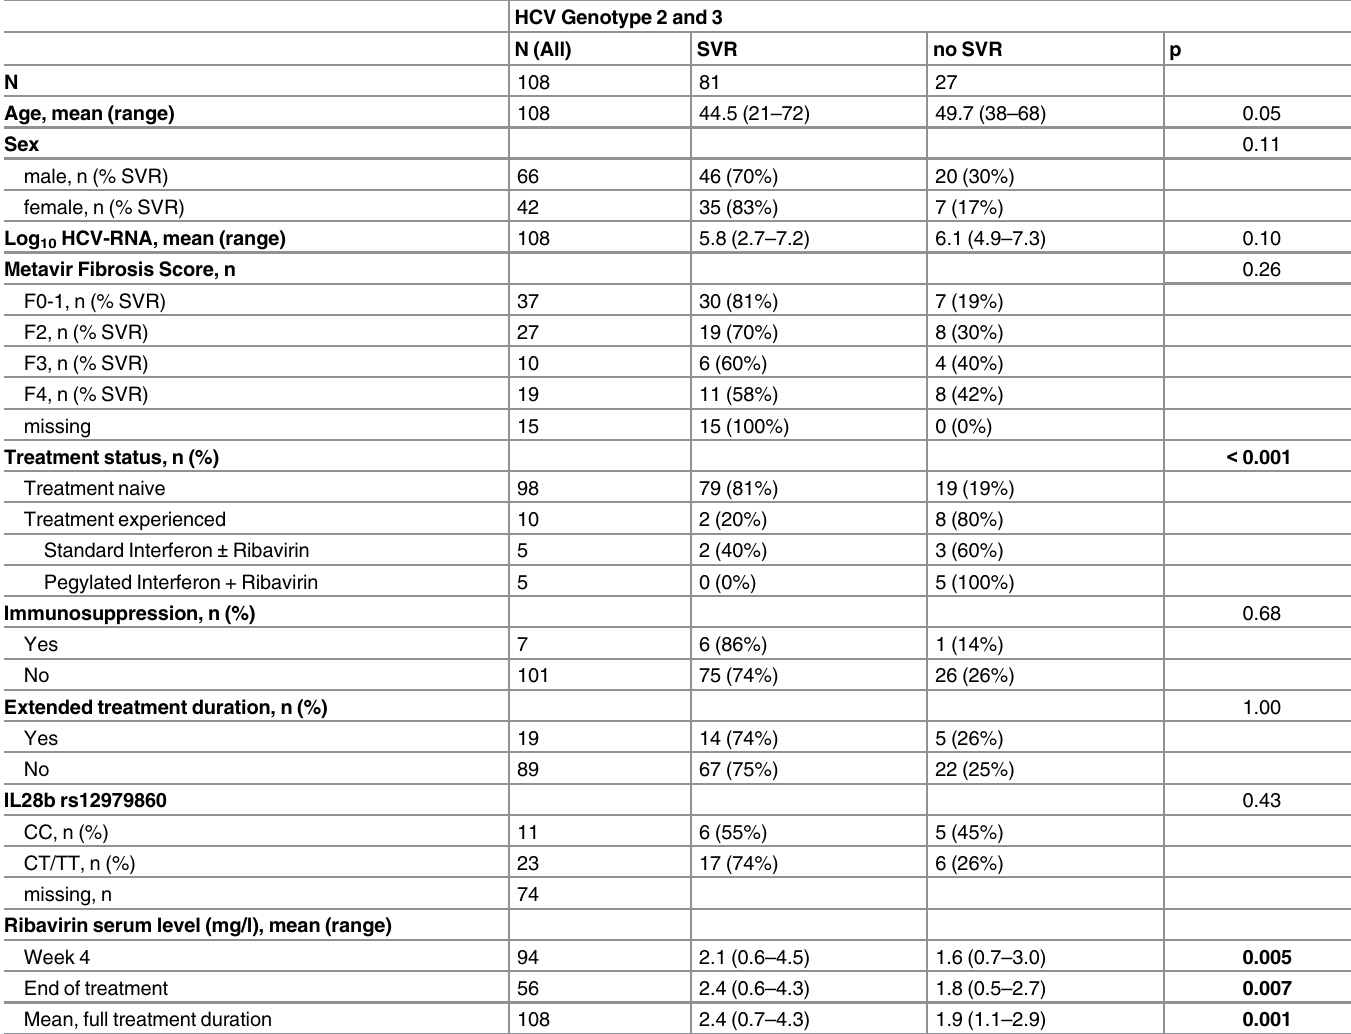
Table 3. Patient characteristics and SVR rates for HCV Genotypes 2 and